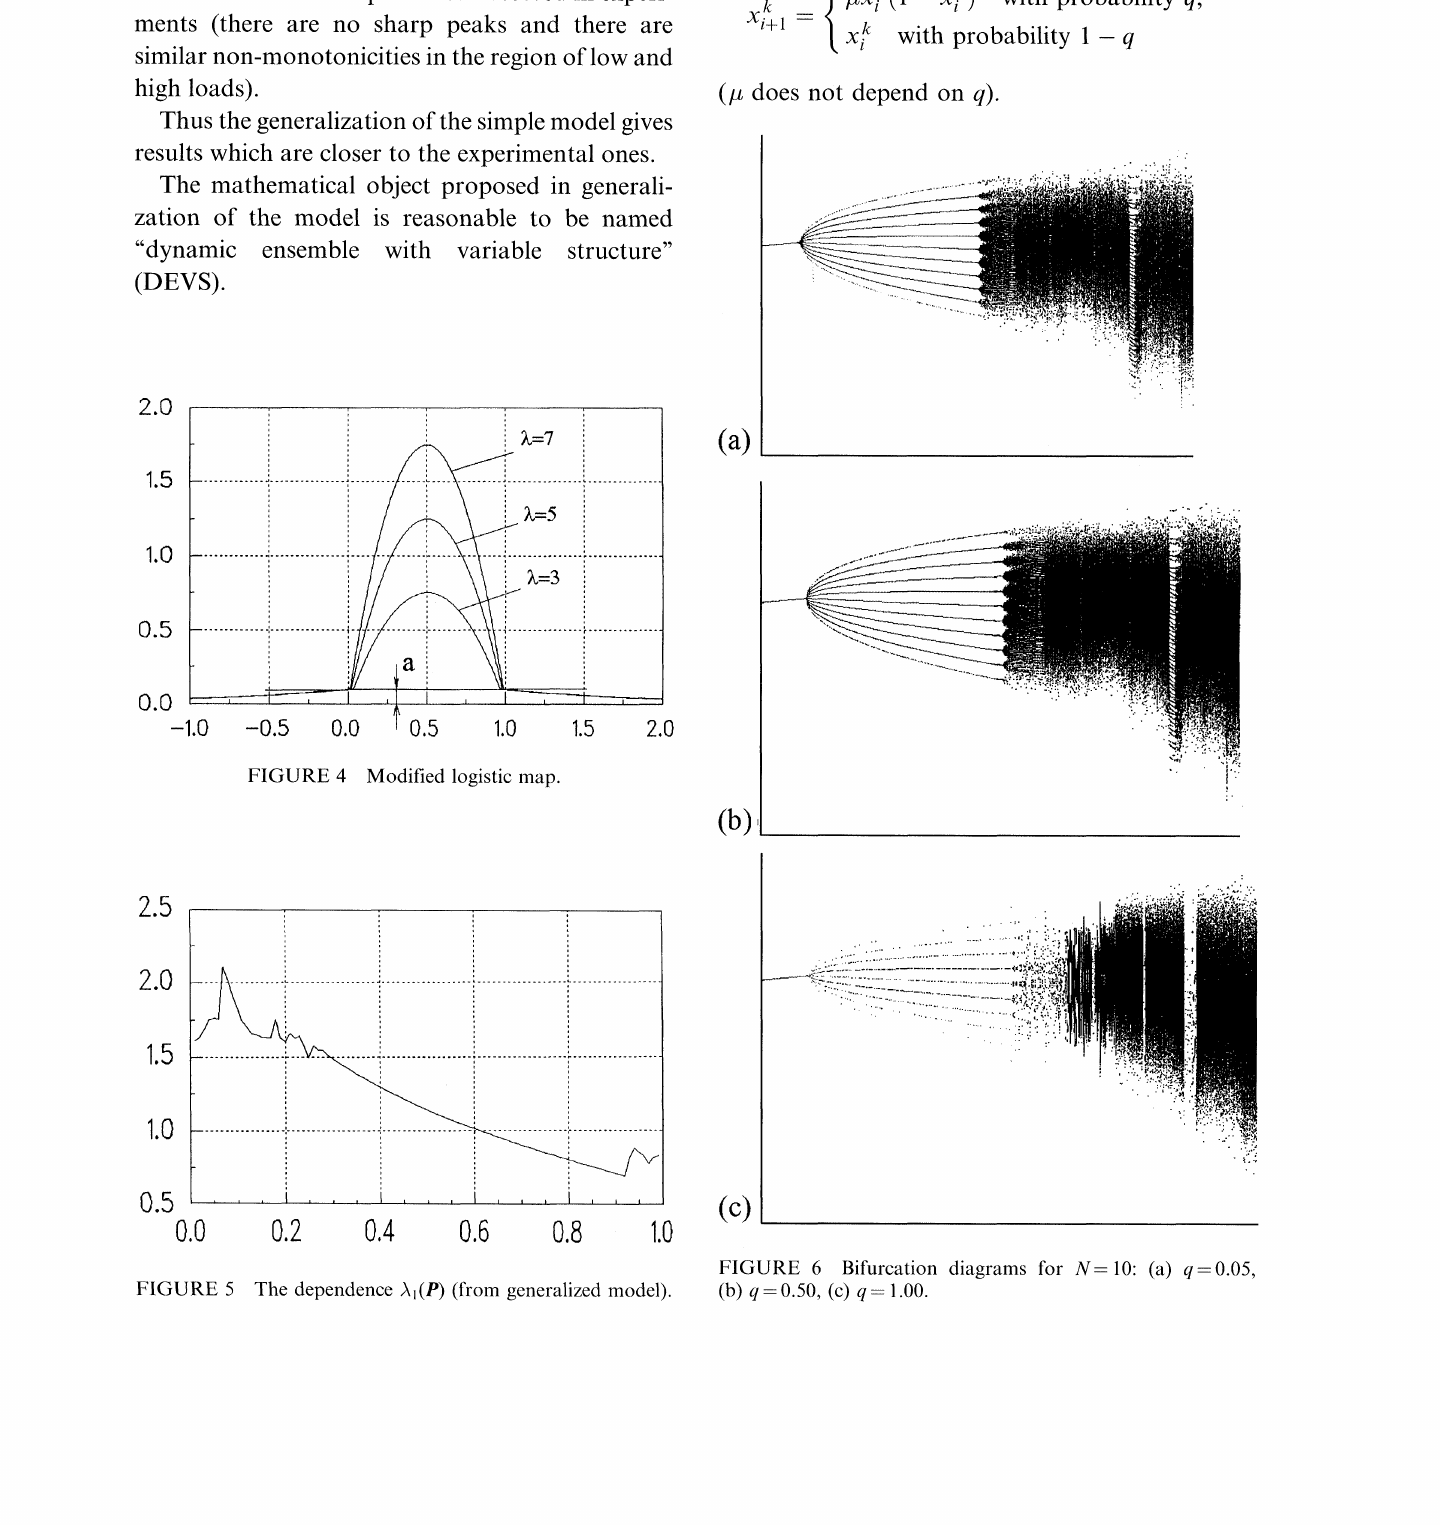
FIGURE 5 The dependence A1(P) (from generalized model).